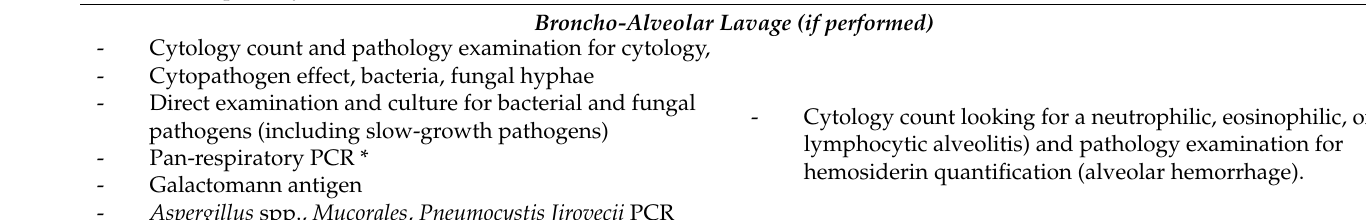
Cytology count looking for a neutrophilic, eosinophilic, or lymphocytic alveolitis) and pathology examination for hemosiderin quantification (alveolar